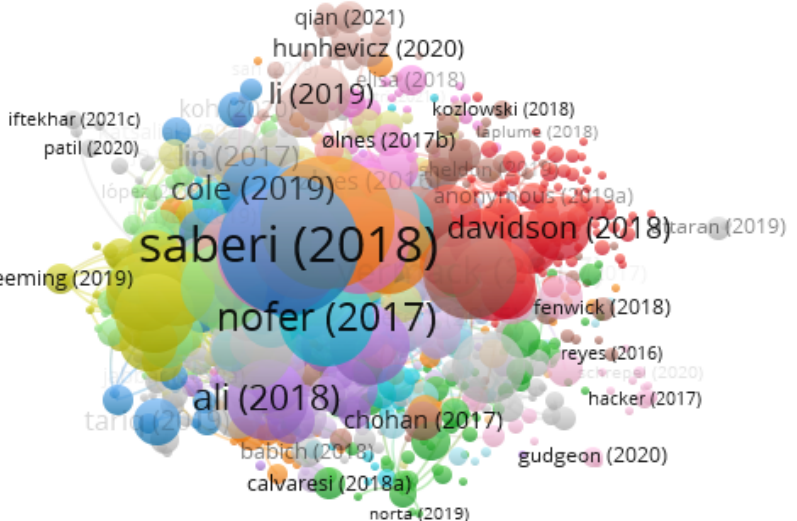
Figure 2. VOSviewer mapping of blockchain technology and smart contracts in decentralized governance systems regarding citation.